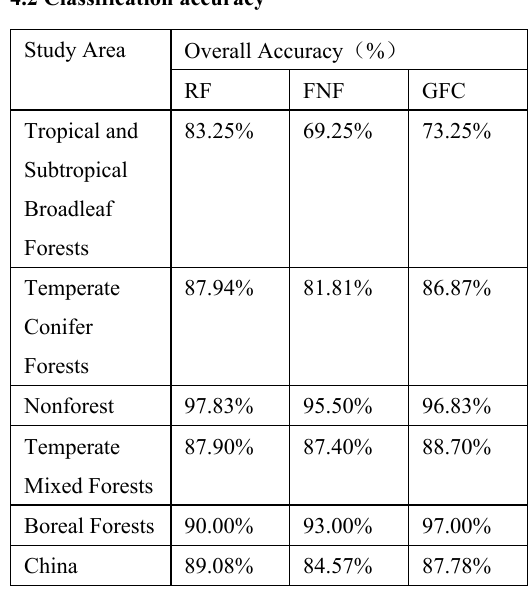
Table 3. The overall accuracy of the three